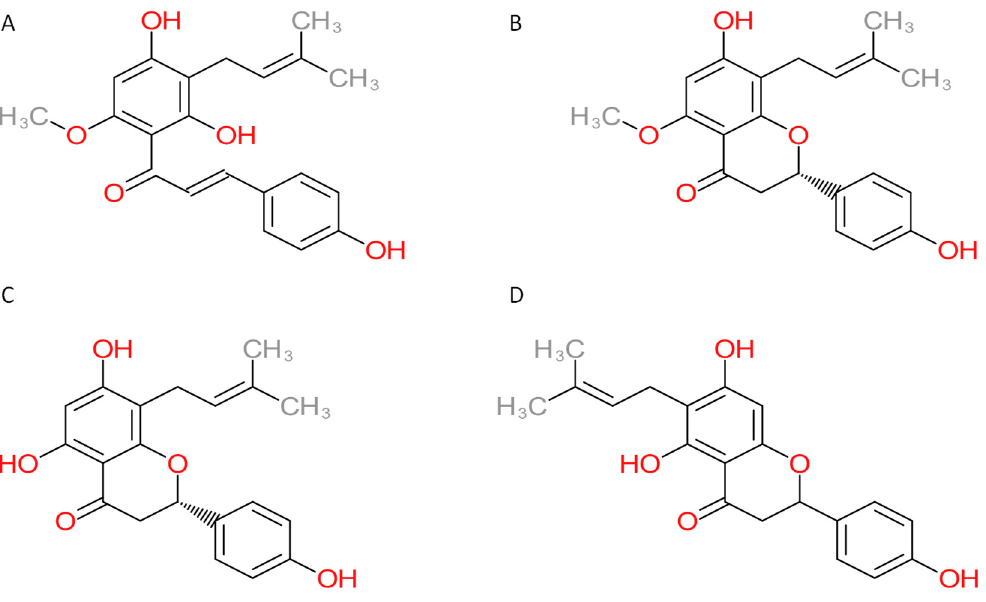
Figure 1. Chemical structures of compounds: ( A ) xanthohumol, ( B ) isoxanthohumol, ( C ) 8-prenylnaringenin, and ( D ) 6-prenylnaringenin.